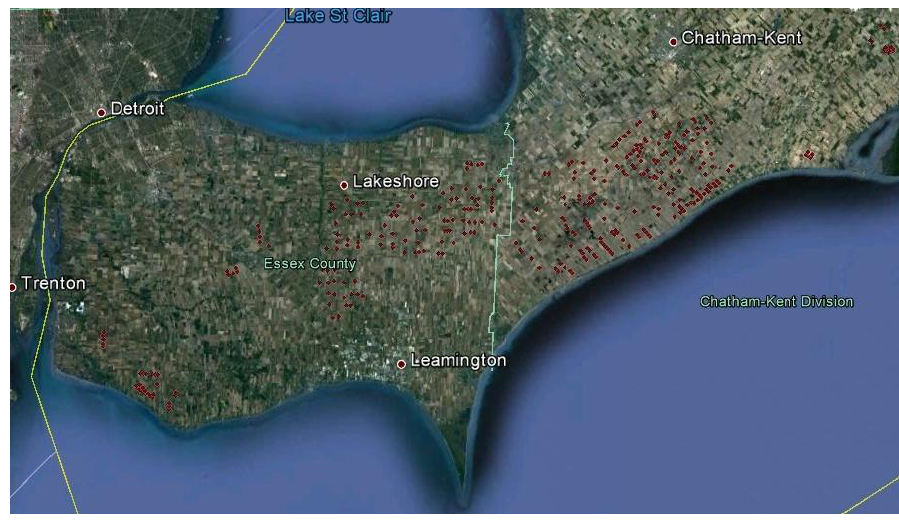
Figure 2. Wind turbines mapped between Chatham-Kent and Windsor,